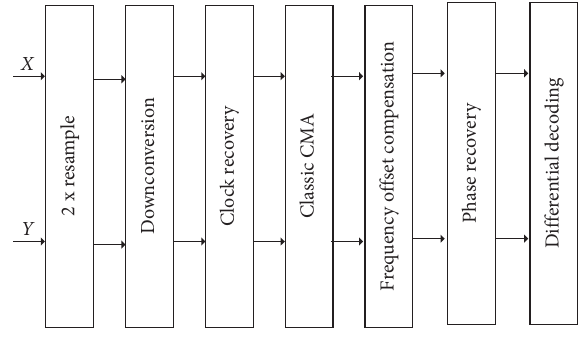
Figure 13: DSP algorithm flowchart at